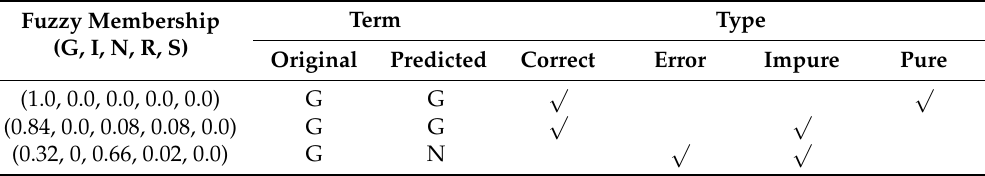
Table 5. Different types of fuzzified samples.